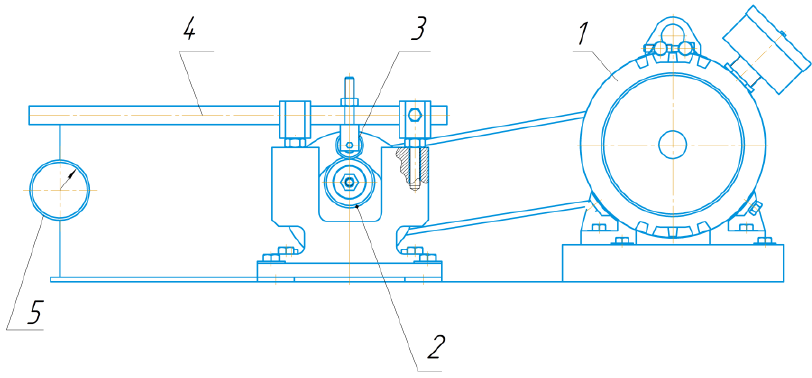
Fig. 2. Experimental setup